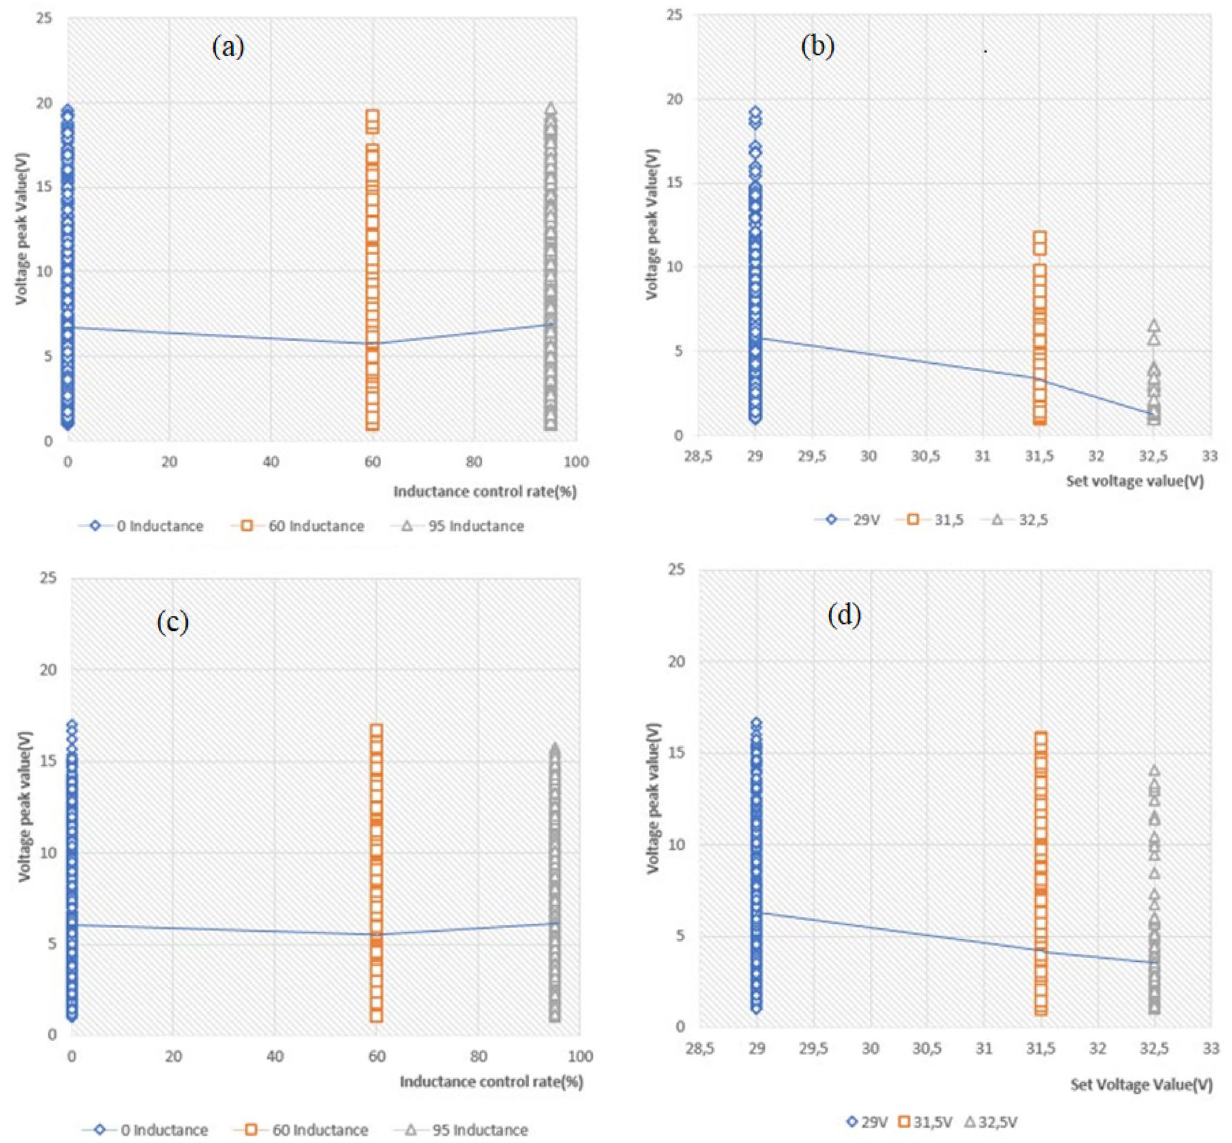
Voltage values vs set voltage value; c . Positive peak voltage values Vs inductance control rate; d : Positive peak voltage values Vs set voltage